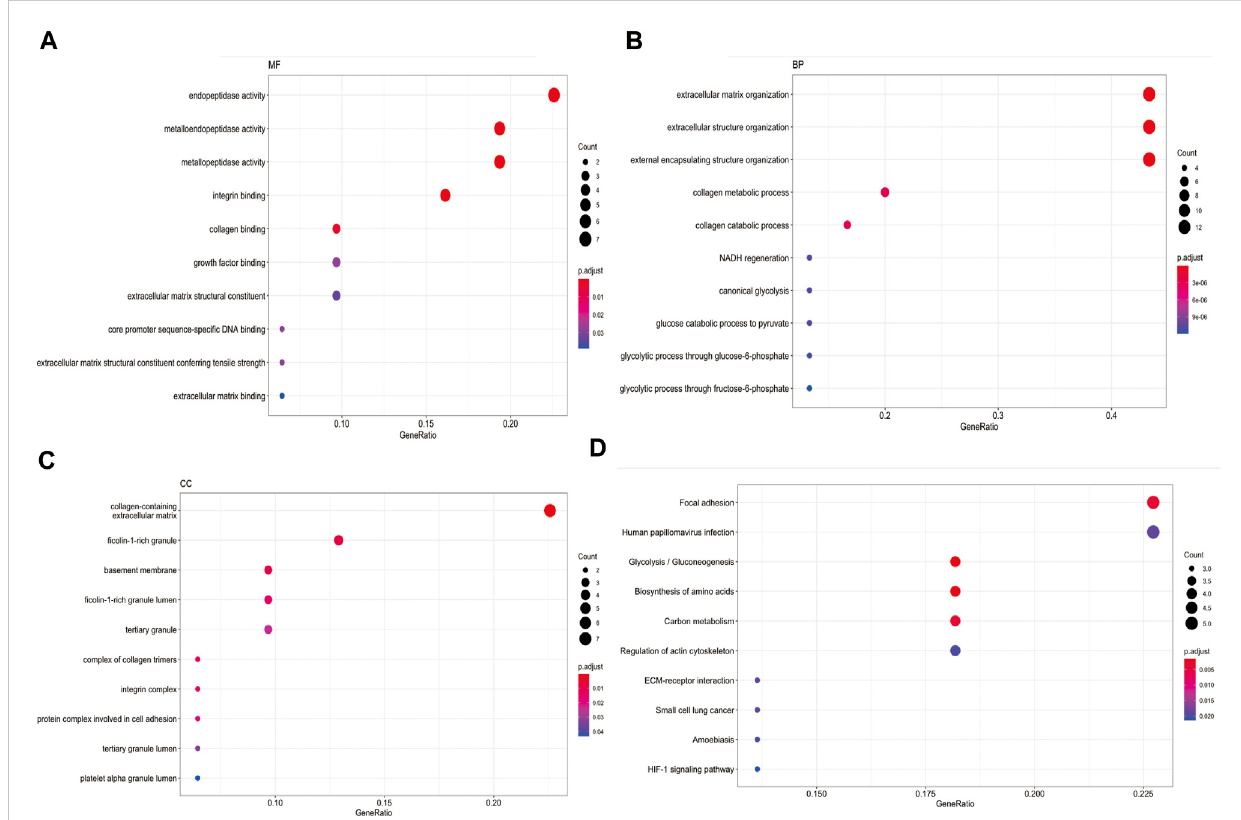
FIGURE 2 Enrichment analysis in31 CAFs genes (A) MF function analysisfor 31 CAFsgenes. (B) BP function analysisfor 31 CAFs genes. (C) CCfunction analysis for 31 CAFs genes. (D) KEGG pathway analysis for 31 CAFs